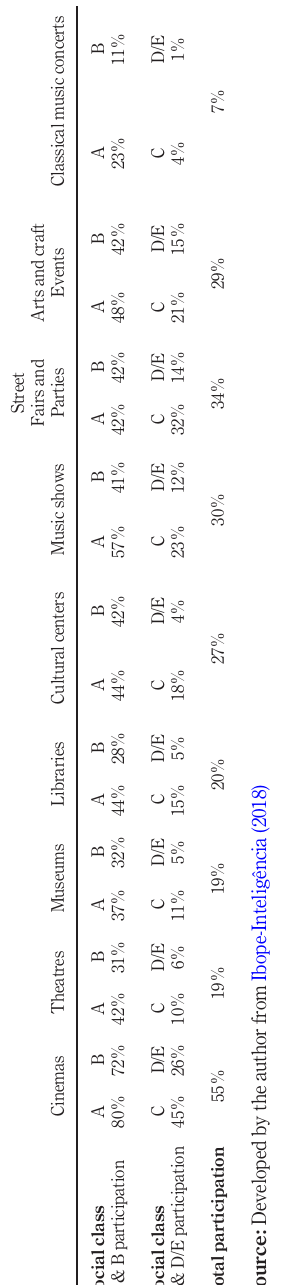
Table 2. Participation